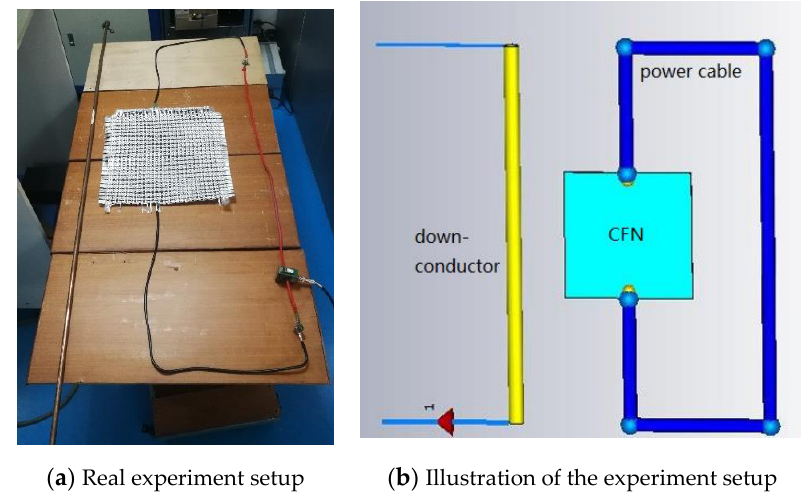
Figure 5. Experiment setup and illustration.